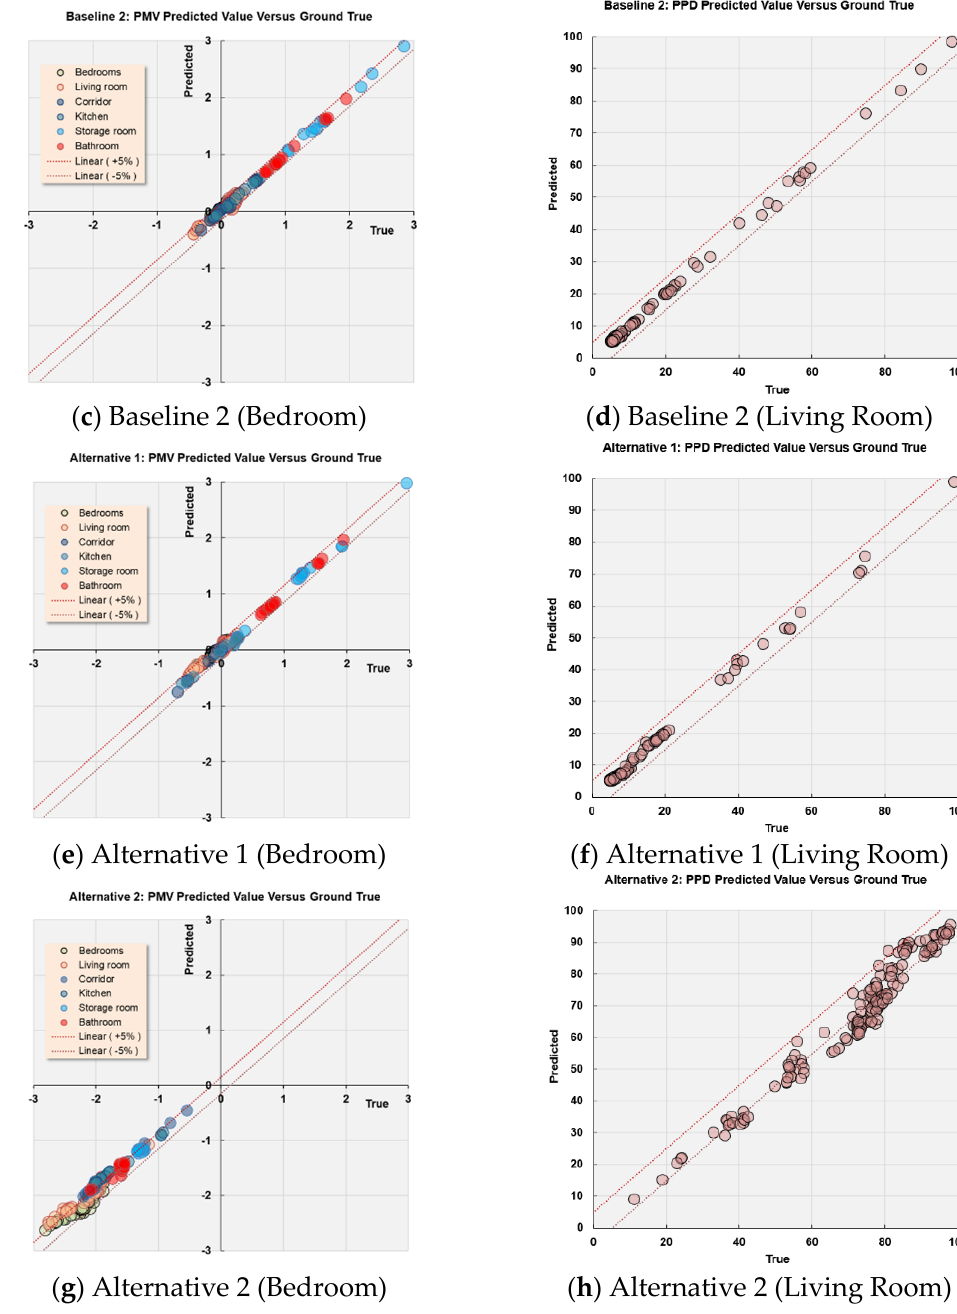
Figure 15. Predicted value versus ground truth for different design options.